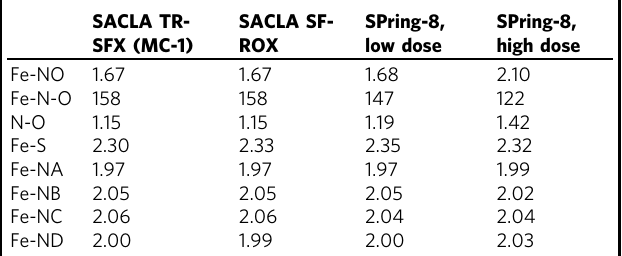
Table 1 Geometrical parameters (in Å and °) for the NO coordination in the ferric NO complex of P450nor SACLA TR- SACLA SF- SPring-8, SPring-8, SFX (MC-1) ROX low dose high dose